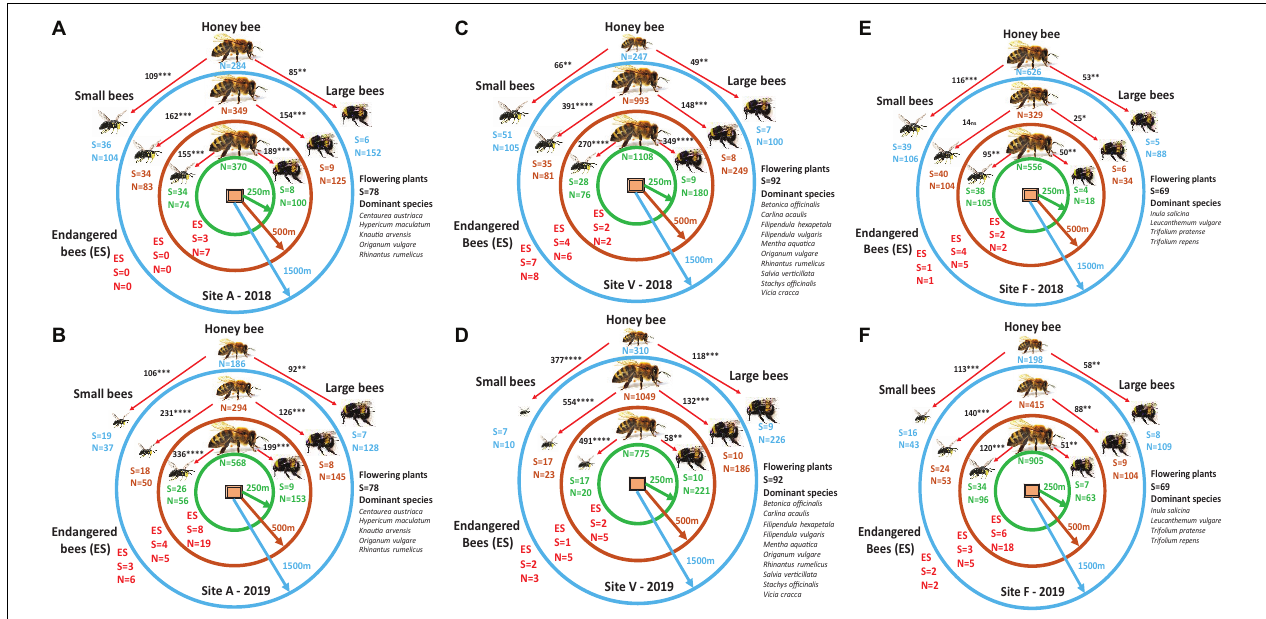
FIGURE 4 | The variation in the densities of honeybees as well as small and large bees for each site, year, and distance from beehives, respectively [multivariate ANOVA (MANOVA)], and interactions tested using χ 2 tests on the differences between the covariance matrices and by the root mean square error of approximation. The initial comparison was made between the densities of honeybees and the densities of small and large bees for each distance separately. Due to the low density of endangered species, comparisons were made without statistical analyses. S, number of species; N, number of individuals. Green circles represent 250 m, brown circles represent 500 m, and blue circles represent 1,500 m distances from beehives. Chi-square values are presented in black inside figures, ∗∗∗ P < 0.001, ∗∗ P < 0.01, NS denotes not significant. TABLE 1 | The effect of years, sites, and distances on honeybee, small bees, and large bees, respectively, on endangered species (relative proportion found in each sampling data) using each species group as a response variable and the sites, years, and distances as explanatory variables.